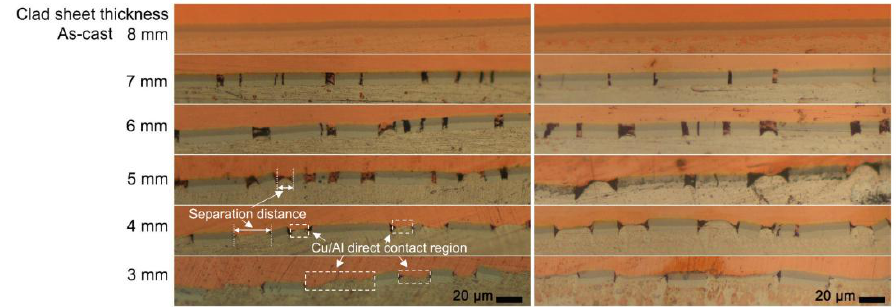
Figure 5. Interfacial microstructure of the Cu/Al clad sheets with different thicknesses after multi-pass rolling ( left side ) and annealing ( right side ). Table 3. Ratio of Cu/Al direct contact region to the interface layer, average width of Cu/Al direct contact region, and the number of Cu/Al direct contact region per millimeter with different thicknesses of the clad sheets.